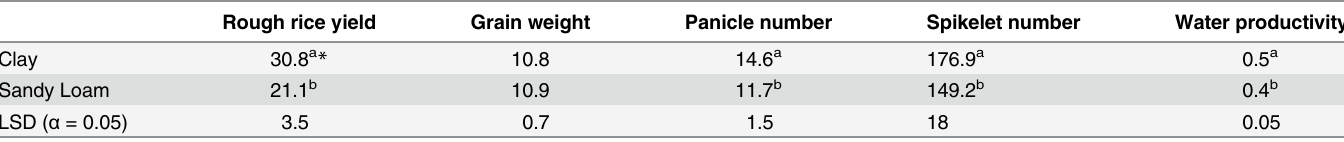
Table 3. The effect of soil texture on rice